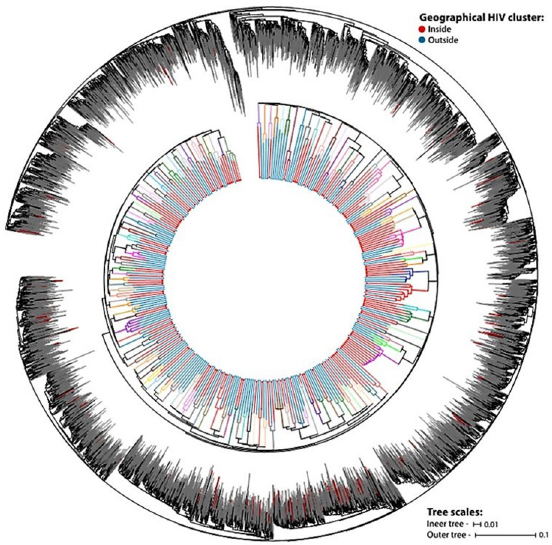
Fig 1. HIV-1 Pol gene maximum likelihood trees. The outer tree shows the identification of the target phylogenetic transmission cluster (red branches) in a background of a control dataset with sequences from Southern African countries (gray branches). The inner tree depicts the identified clusters (in different colors) and the geographical location of the sampled individuals (according to the legend at the top